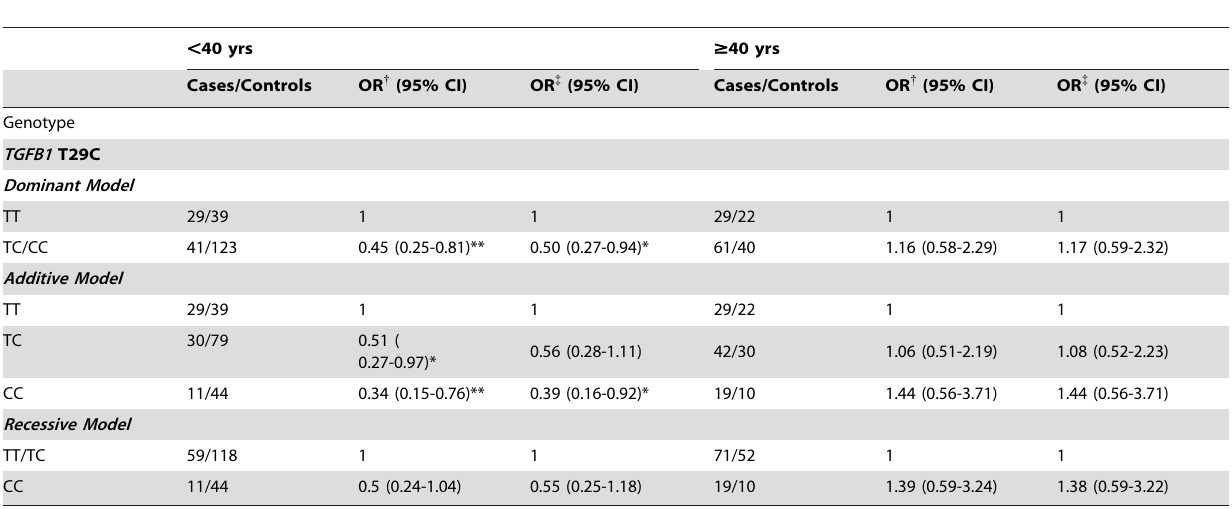
Table 4. TGFB1 T29C gene polymorphism and risk for breast cancer in Maharashtrian subjects with respect to the age of onset.